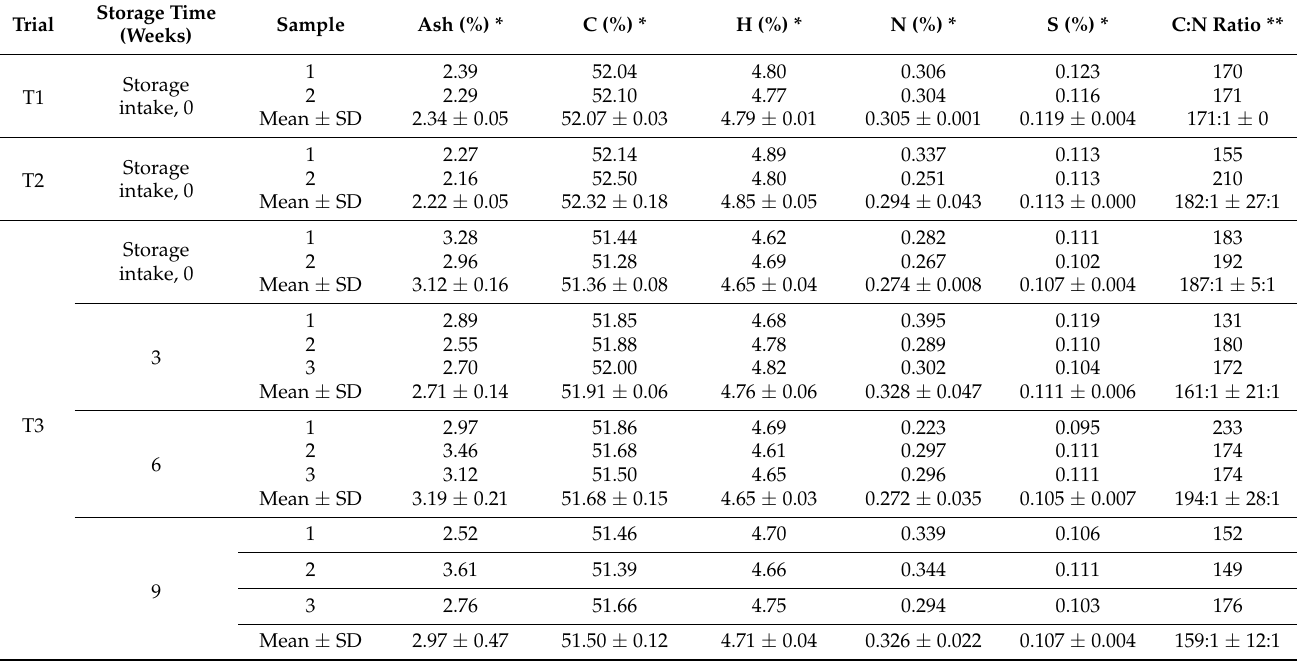
Table A7. Results of the elemental analysis and ash